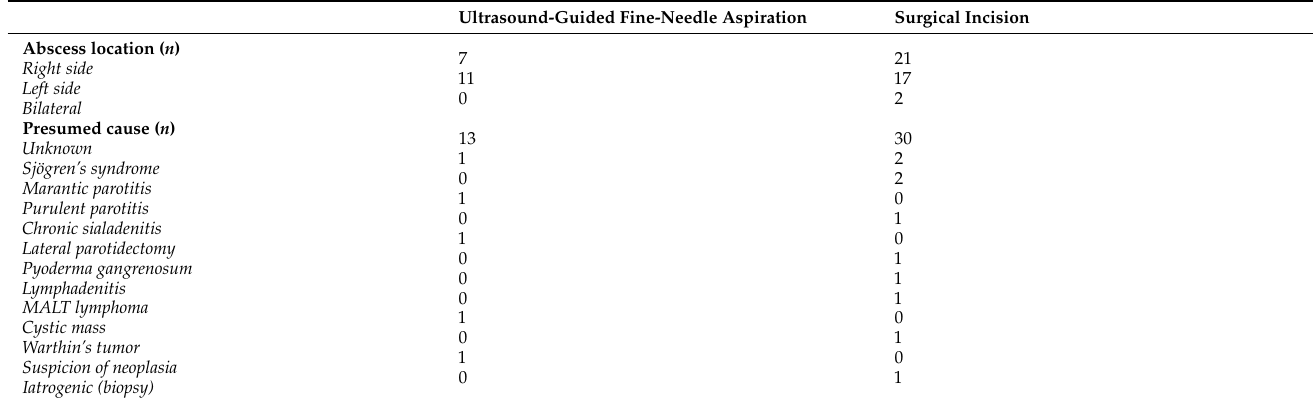
Table 2. Abscess location and presumed cause of parotid abscess (where available). Ultrasound-Guided Fine-Needle Aspiration Surgical